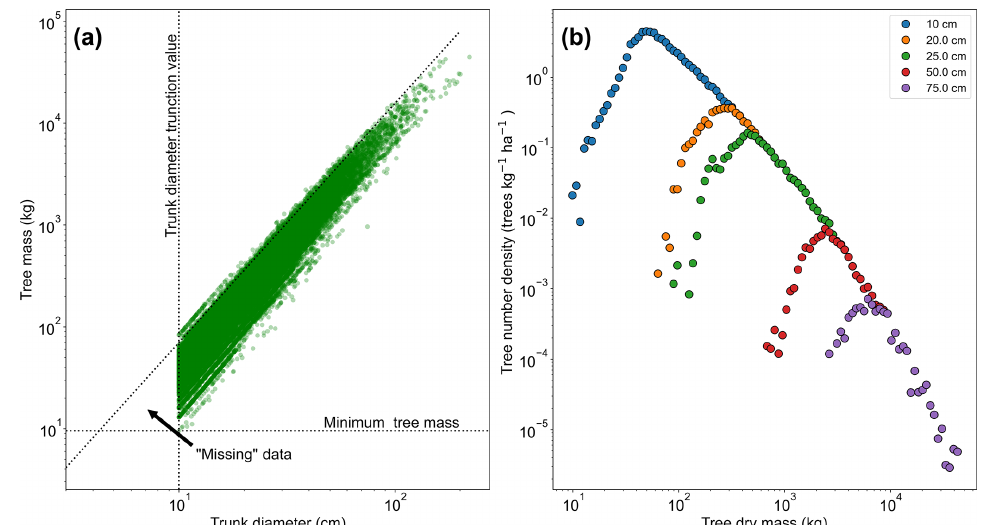
Figure 2. The effect of truncating data measured in trunk diameter and then converting to mass using allometry. In (a) , the mass for each tree is shown in terms of its trunk diameter. If the data had been truncated based on mass there would be data in the triangle marked by the intersection of the dotted lines. This truncation effectively leads to missing data in the mass distribution, as seen in (b) . The mass distribution should constantly decrease with increasing mass but instead rises to a peak and then decreases due to incomplete data for the low-mass end of the distribution. This peak can be seen to be an artefact of the trunk diameter truncation point. When the trunk diameter truncation point is increased the mass distribution peak moves with the truncation point.